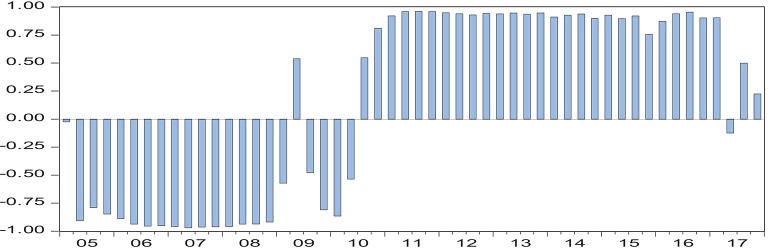
Dynamic correlation coefficient between China's economic growth and the health of residents1.